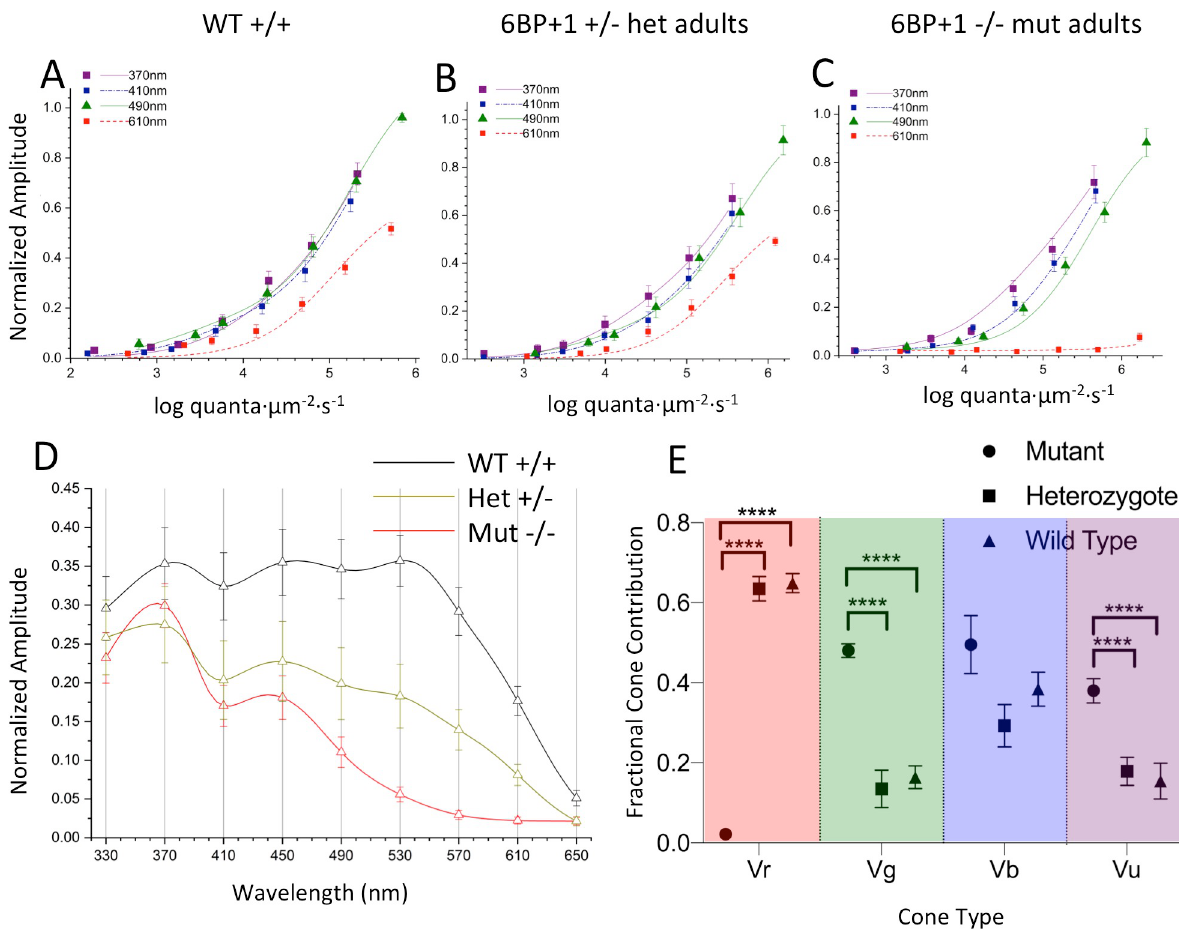
Fig 15. Spectral analysis of 6BP+1 adults. (A, B, C) The irradiance plots for each genotype showed the loss of response to 610 nm in the mutant regardless of brightness. (D) The spectral plot showed a significant loss of amplitude in the heterozygote (N = 9) and mutant (N = 12) at long wavelengths compared to the WT (N = 11). (E) The mutant shows loss of Vr, increase in Vg, and increase in